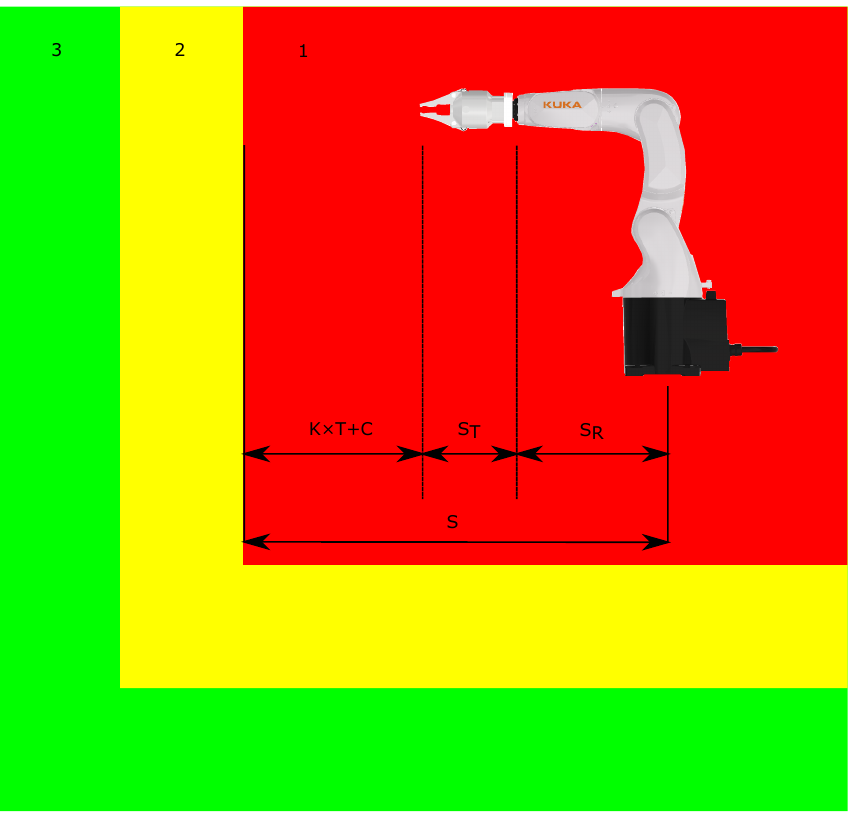
Figure 1. Minimum distance calculation